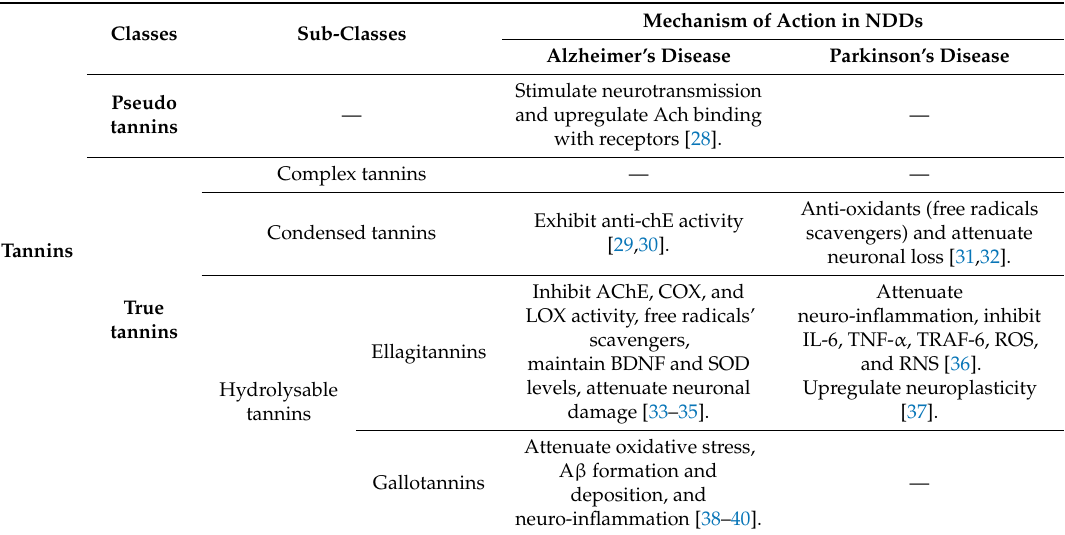
Table 1. Classification, sources and neuroprotective roles of